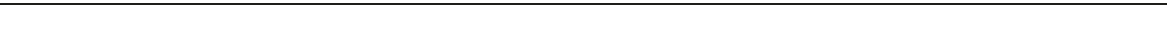
Fig. 2 Analysis of PGAP4-KO cells. a Left. 3BT5 CHO cells (top) and 3BT5-PGAP4-KO cells stably harboring pLIB2-Hyg (Vec) or pLIB2-Hyg-hPGAP4-3HA (PGAP4) were stained with T5 mAb. Dotted lines, background staining. Right. Mean fl uorescence intensity ( ± SD) from three independent experiments ( n = 3). Statistical analyses were done by unpaired Student ’ s t -test. * p < 0.05; ** p < 0.005. b and c A lack of GalNAc side-chain in GPI of CD59 in PGAP4- KO cells. GPI-containing peptide from PI-PLC-treated CD59 was analyzed by MALDI-TOF-MS ( b ) or LC-ESI-MS/MS ( c ). b The C-terminal peptide containing GPI after trypsin digestion is shown (top). The m / z of GPI-containing peptides with or without HexNAc are 2733.9 and 2530.9, respectively. c Quanti fi cation of MS data. Percentage of total intensity (mean ± SD) was calculated from the peak areas obtained by two independent measurements. d Normal levels of GPI-APs on PGAP4-KO cells. 3BT5 cells and 3BT5-PGAP4-KO cells stably harboring pLIB2-Hyg (Vec) or pLIB2-Hyg-hPGAP4-3HA (PGAP4) were stained with anti-CD59 (top), anti-uPAR (center) and FLAER (bottom). Mean fl uorescence intensity ( ± SD) from three independent experiments ( n = 3). Statistical analyses were done by unpaired Student ’ s t -test. Not signi fi cant. e DRM separation experiment. Transferrin receptor (TfR) and Caveolin1 (Cav1) are markers of Triton-soluble (S) and -resistant (R) fractions, respectively. Representative data from two independent experiments. See also Supplementary Fig. 2,